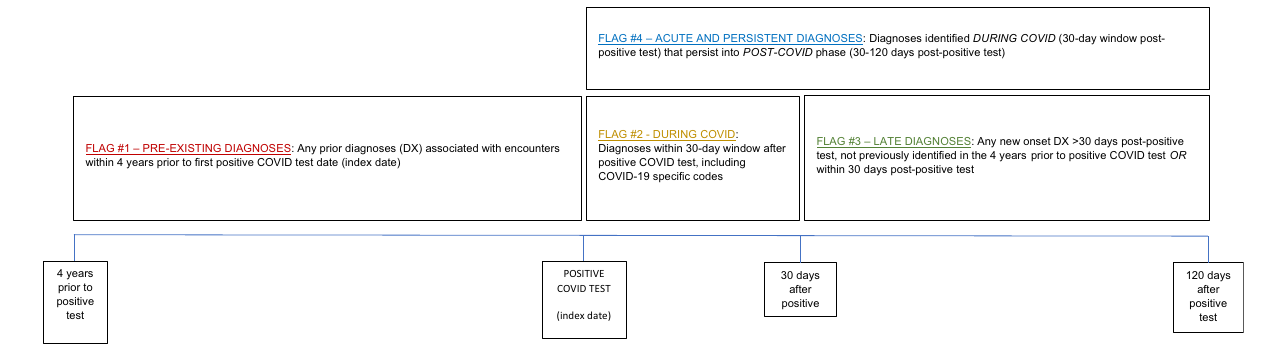
Fig. 2 | Diagnosis Observation Periods. Diagnostic observation timeline for CCS conditionsinrelationtotheCOVIDtestingdateastheindexdate.Thetimeperiods used in thisstudy were de fi ned asfollows:Late: 30 – 120days post COVID